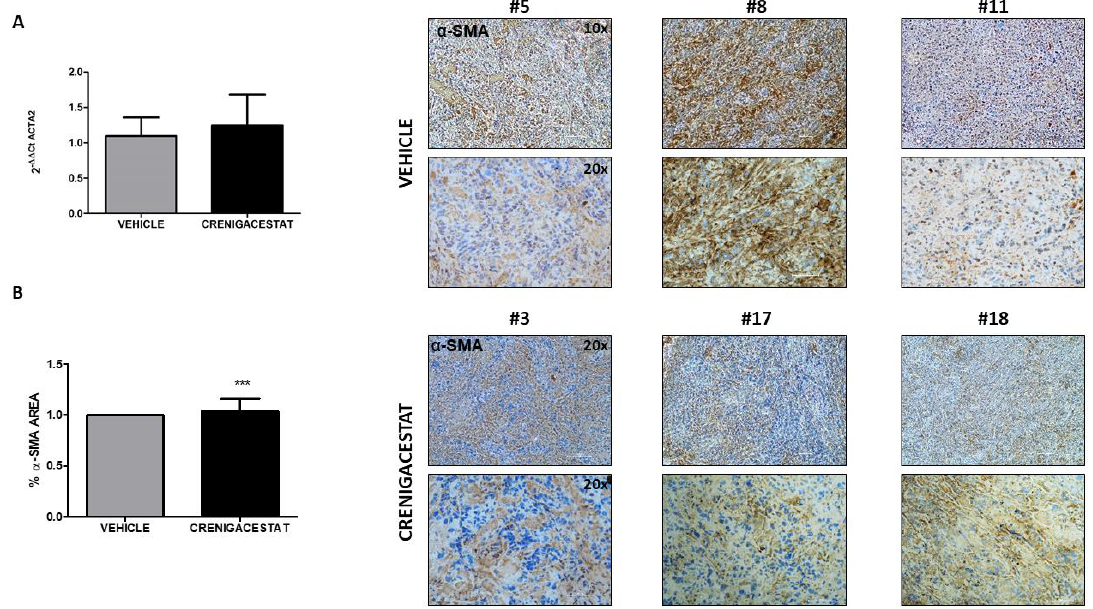
Figure 8. Crenigacestat has no effect on α -SMA expression in the HuCCT1-xenograft model. ( A ) RNA and ( B ) protein expression of murine α -SMA were analyzed in HuCCT1-xenograft tissues in Crenigacestat and vehicle-treated mice. Representative images of treated ( n = 6) and untreated ( n = 8) animals reveal no differences in tissues in both groups, confirmed by quantitative analysis of positive staining to the total area in tissues of HuCCT1-xenograft mice. These results indicate that Crenigacestat is not able to modulate fibrosis in this model (***p < 0.001). The images were acquired at 10× and 20× magnification. Scale bar represents 100 μm and 50 μm , respectively.